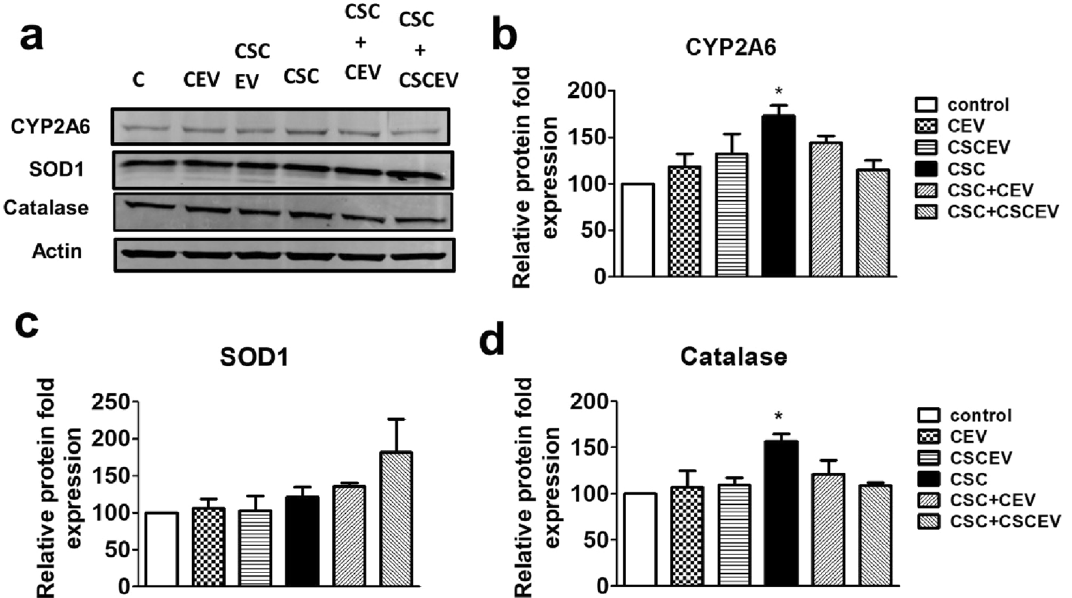
Figure 4. Expression of CYP2A6 and antioxidant enzymes in SVGA cells that received EVs derived macrophages. The SVGA cells (0.1 million cells/well/12well plate) were treated with EVs derived from control (DMSO) and CSC-exposed (10 µg/ml/day for 7 days) U937 macrophages once daily for 3 days. After 3 days of treatments, Western blot was performed with an equal amount of protein loaded (5 µg of protein) ( a ) to measure the expression of CYP2A6 ( b ), SOD1 ( c ), and catalase ( d ). One-way ANOVA with Tukey’s multiple comparison test was used to find the significance among the groups. CEV represents EVs isolated from the control group; CSCEV represents EVs isolated from the CSC-treatment group. *, **, and *** represent p < 0.05, p ≤ 0.01, and p ≤ 0.001 respectively when compared to control; #, ##, and ### represents p < 0.05, p ≤ 0.01, and p ≤ 0.001 respectively when compared to